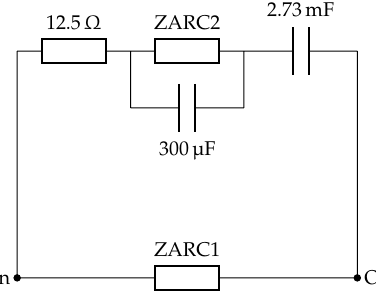
Figure 16. Fuel cell simplified fitted